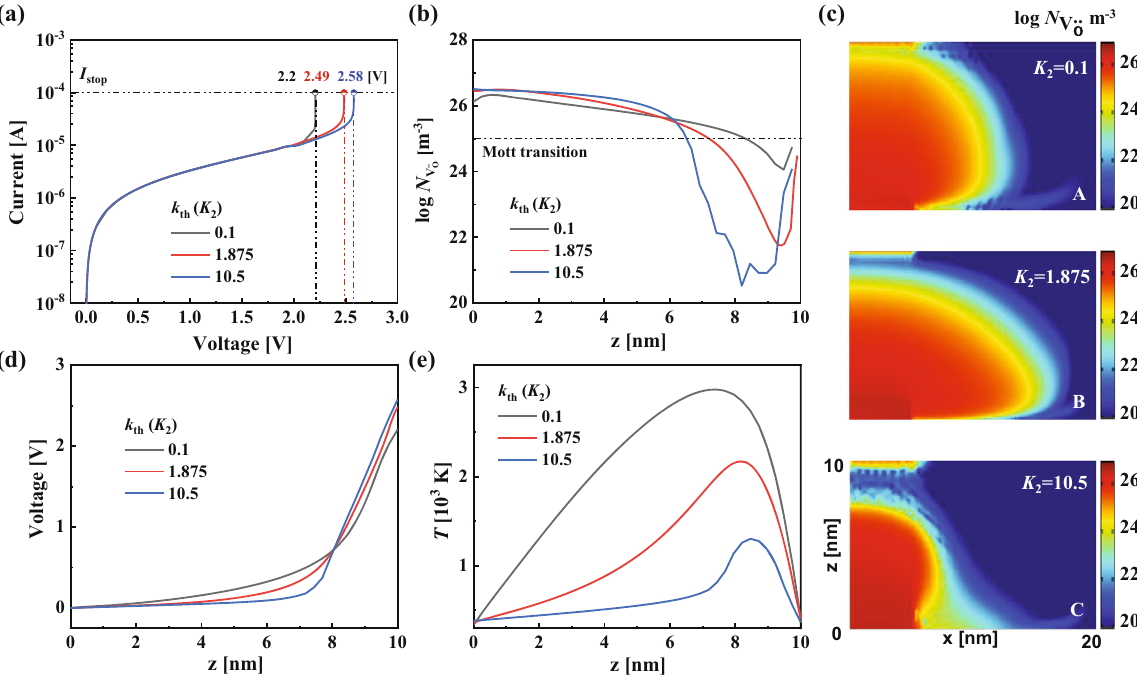
Fig. 5 Effect of thermal conductivity on the CF growth. a Current characteristic with different thermal conductivity (by K 2 ) under a voltage ditributions along the center of CF ( x = 0, z = 0 – 10 nm) at fi nal state. c Calculated 2D N V :: sweep rate d V /d t = 1 V s − 1 . b N V :: o d , e Calculated 1D pro fi les of local electrical potential φ and temperature T along the center of CF ( x = 0, z = 0 – 10 nm) at fi nal